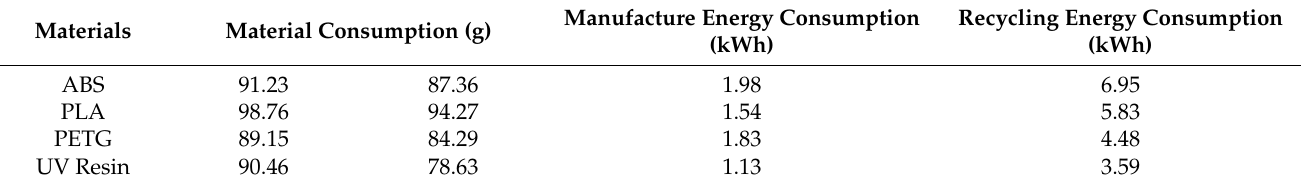
Table 2. Real-time material and energy consumption data for